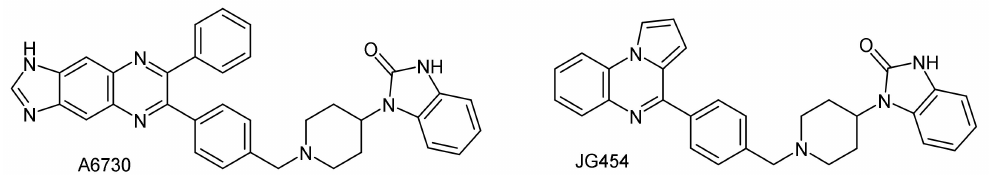
Figure 1. Chemical structures of compounds A6730 and